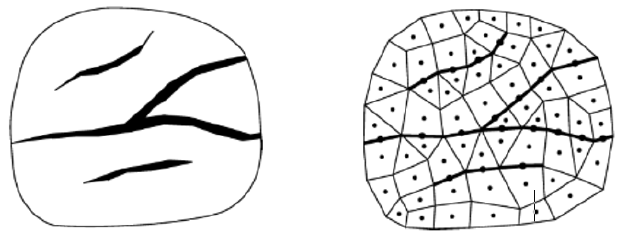
Figure 5. 2D fractured porous medium in discrete fracture model [27].